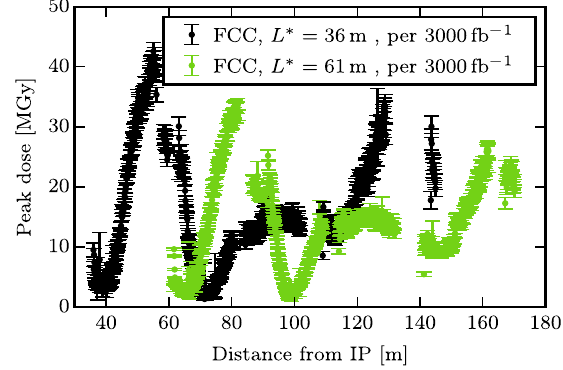
FIG. 9. Comparison of the peak doses per 3000 fb − 1 for the L (cid:2) ¼ 36 m and the L (cid:2) ¼ 61 m lattices with 15 mm shielding.